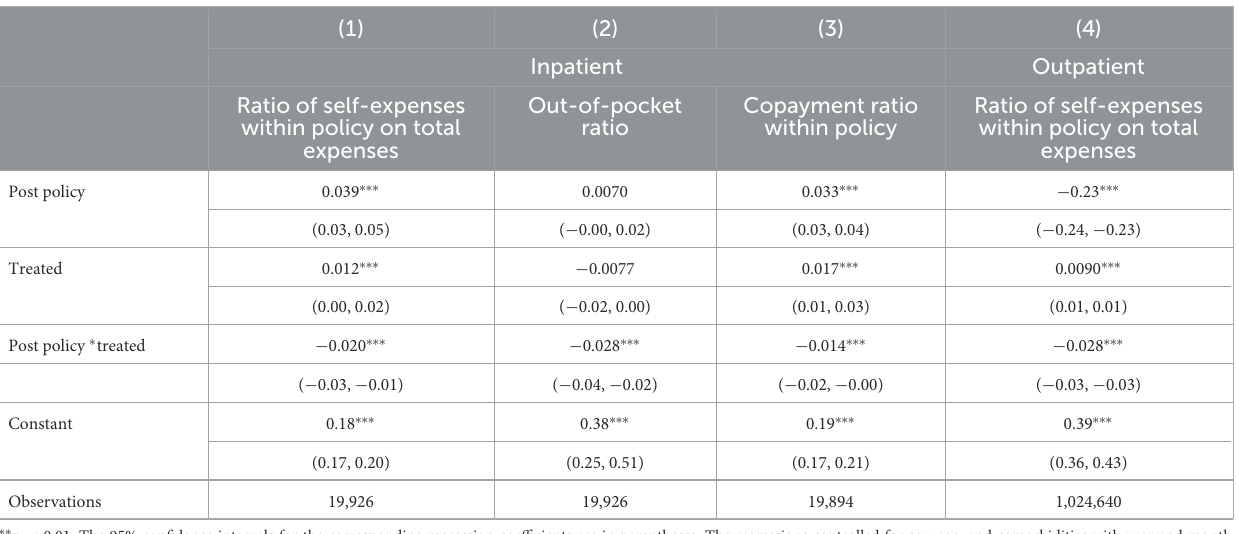
TABLE 9 DID regression analysis of the effect of policy change on cost-sharing ratios per visit.